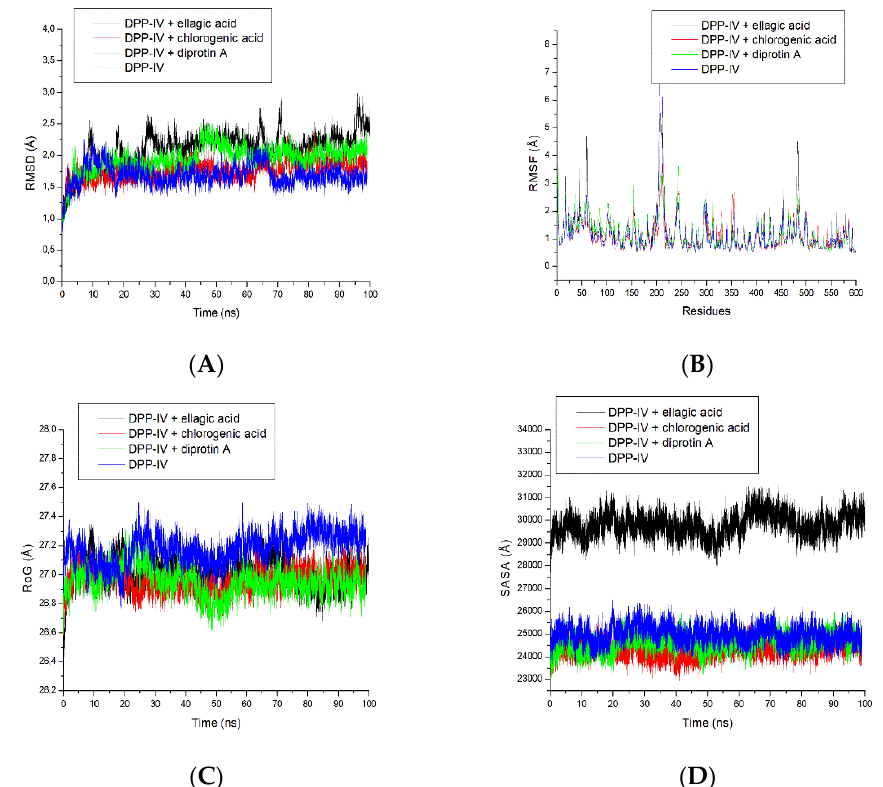
Figure 3. ( A ) Root Mean Square Deviation (RMSD), ( B ) Root Mean Square Fluctuations (RMSF), ( C ) Radius of Gyration (RoG), and ( D ) Solvent Accessible Surface Area (SASA) plots of comparison between Dipeptidyl peptidase-IV (DPP-IV) and chlorogenic acid, ellagic acid and Diprotin A determined over 100 ns molecular dynamics simulations.